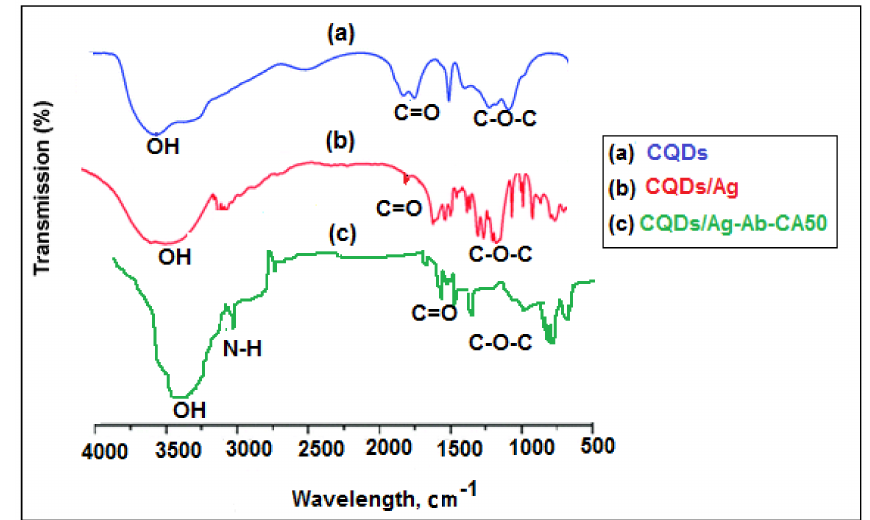
Figure 3. FT-IR spectra of ( a ) CQDs, ( b ) carbon quantum dots/gold (CQDs/Au) nanocomposite and ( c ) immobilized